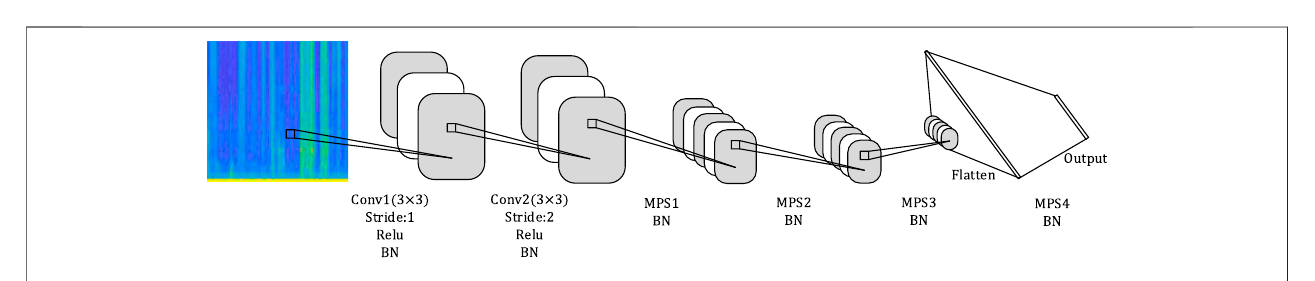
FIGURE 2 | Structure of the neural network model based on the tensor